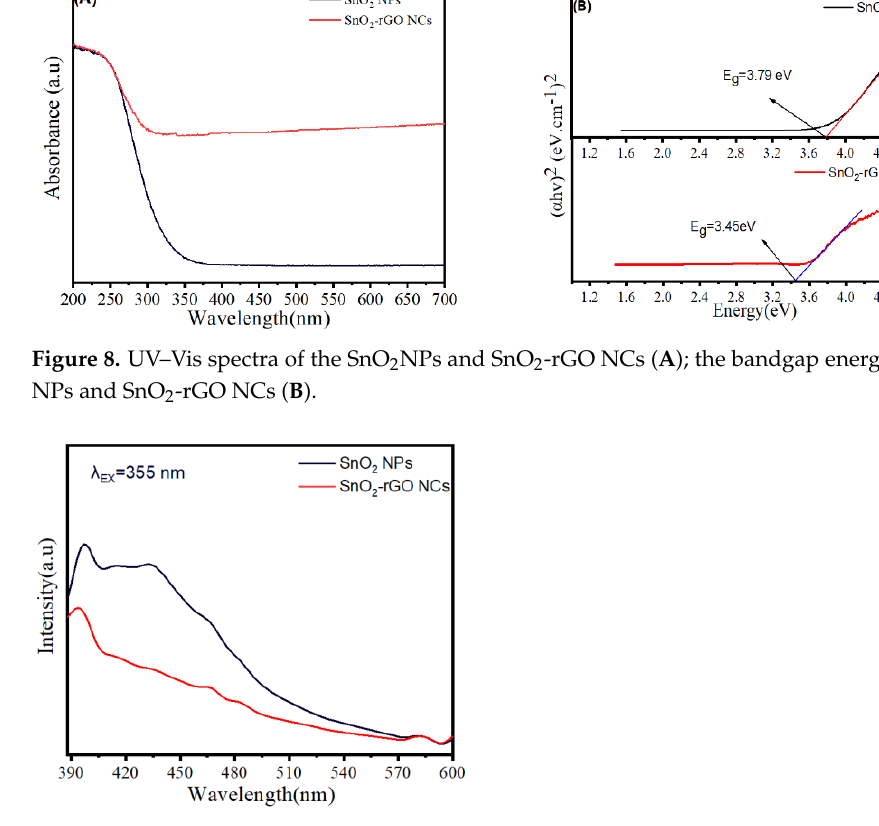
Figure 8. UV–Vis spectra of the SnO 2 NPs and SnO 2 -rGO NCs ( A ); the bandgap energy of the SnO 2 NPs and SnO 2 -rGO NCs ( B ).